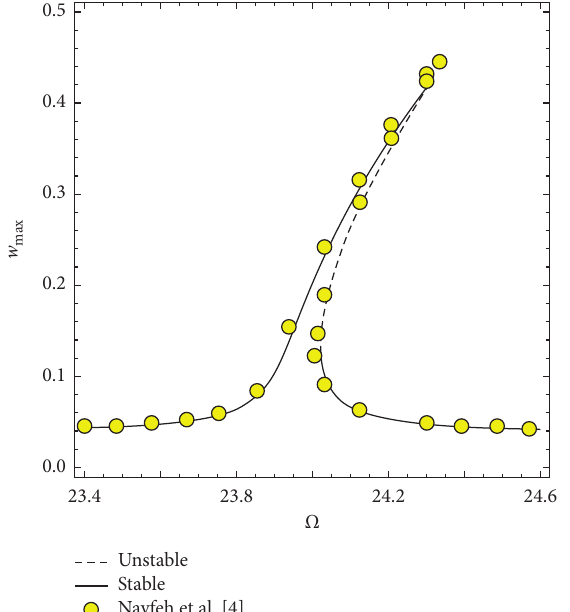
Figure 7: Convergence verification of frequency response curve regardless of the fringing field effect: κ V � 0 . 01 A